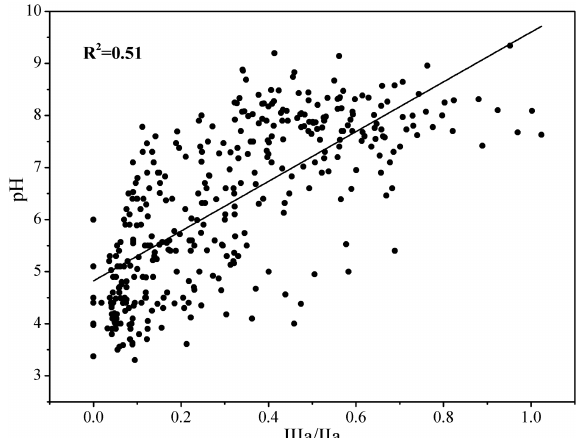
trial components. Sparkes et al. (2015) examined brGDGTs